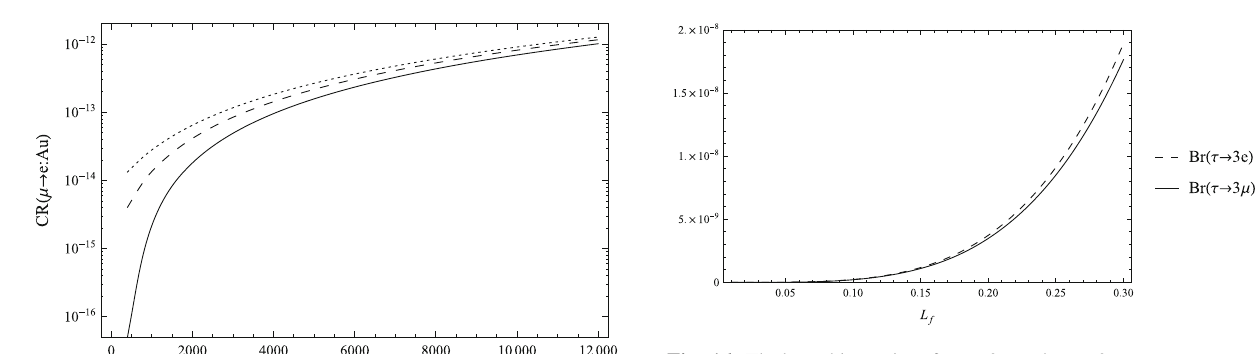
Fig. 16 Thebranchingratiosof τ → 3 μ and τ → 3 e versusparameter L f are plotted by the solid line and dashed line respectively